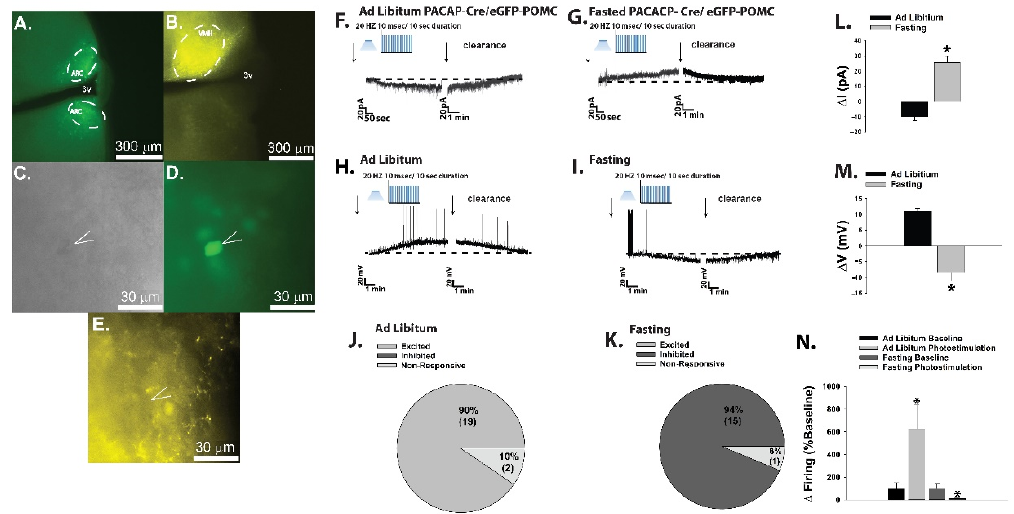
Figure 5. Optogenetic stimulation of VMN PACAP neurons depolarizes POMC neurons and increases their firing under ad libitum-fed conditions, effects which are flipped under fasting conditions. ( A ) , Low power (4 × ) image of ARC POMC neurons taken from a PACAP-Cre/eGFP POMC mouse. ( B ), Photomicrograph (4 × ) showing the channel rhodopsin-2 expression in VMN PACAP neurons two weeks after AAV injection as visualized by eYFP. (C), Differential interference contrast image (40 × ) of a recorded POMC neuron and the corresponding eGFP fluorescence signal from the same neuron ( D ). ( E ), 40X image showing the eYFP-labeled fibers in the immediate vicinity of the recorded neuron. Photostimulation (10-ms pulses delivered at 20 Hz for 10 s) of male VMN PACAP neurons produces a reversible inward current linked to membrane depolarization and increase in the firing of ARC POMC under ad libitum-fed conditions neurons ( F , H , J , L – N) ; n = 7–11), and the exact opposite is seen under fasting conditions (G , I , K – N ); n = 11–13 ) . Bars represent means, and lines 1 SEM of the light-induced change in ∆ I ( L ), ∆ V ( M ) and firing rate ( N ). * p < 0.05, relative to ad libitum-fed conditions, Student’s t -test ( L , M ); relative to baseline, Kruskal–Wallis/median-notched box-and-whisker analysis ( N ). Figure adapted from